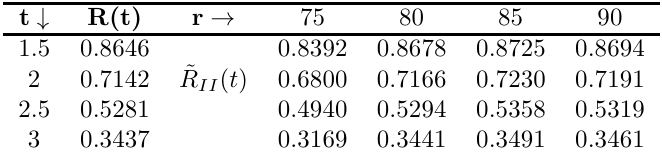
UMVUE’s of R(t) obtained under Type-II censoring